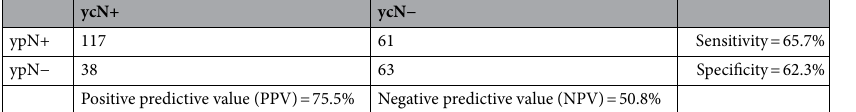
Table 2. Clinical and pathological nodal assessment after NAC. AUS axillary lymph node ultrasound.